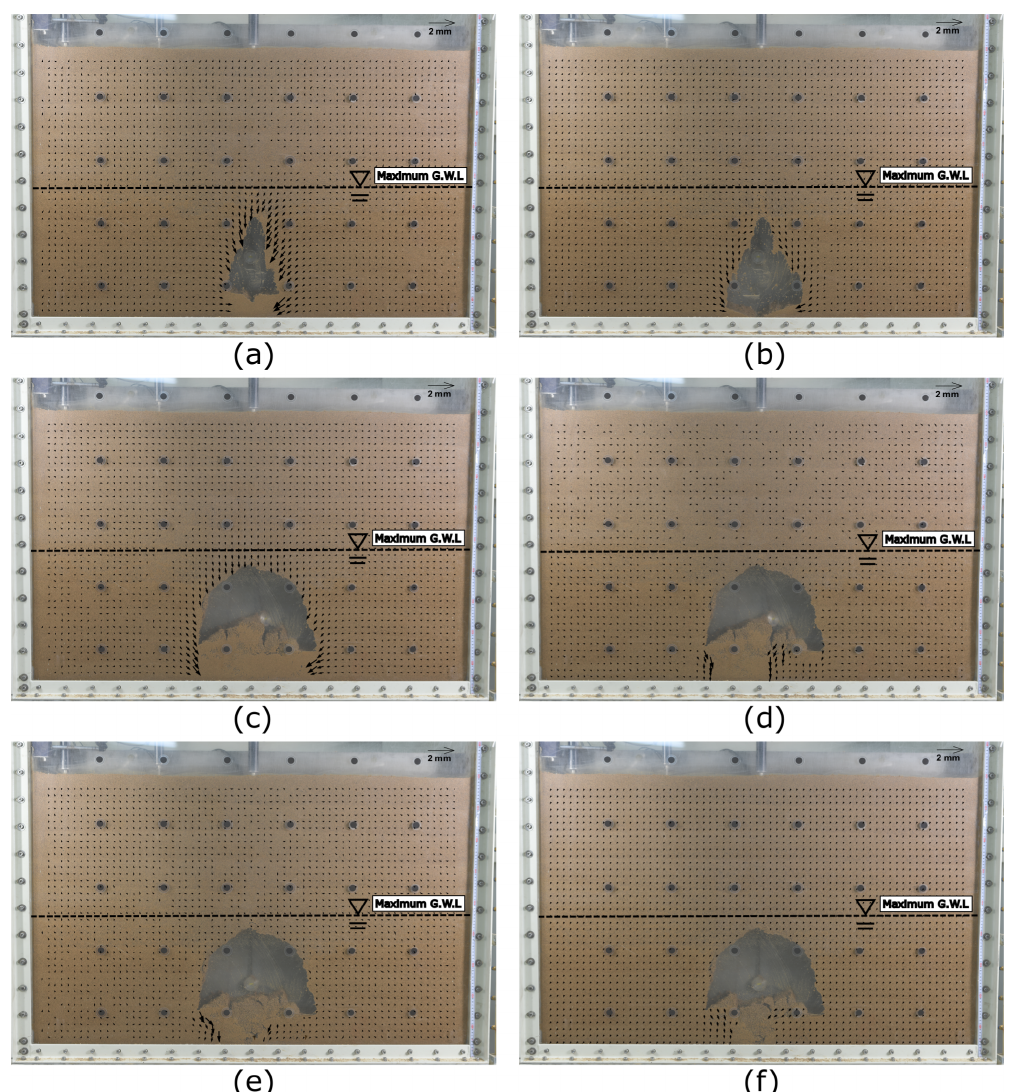
Figure 4. Displacement increment vectors inside the model ground for Test 1 during the water drainage stage: (a) 0–30s, (b) 30–60s, (c) 60–90s, (d) 90–120s, (e) 120–150s, and (f)